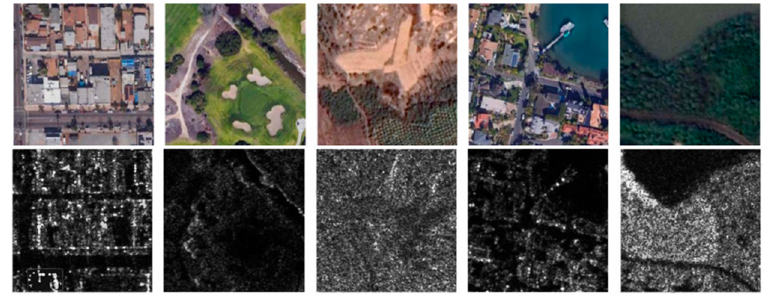
Figure 10. A sample diagram of the QXS dataset.